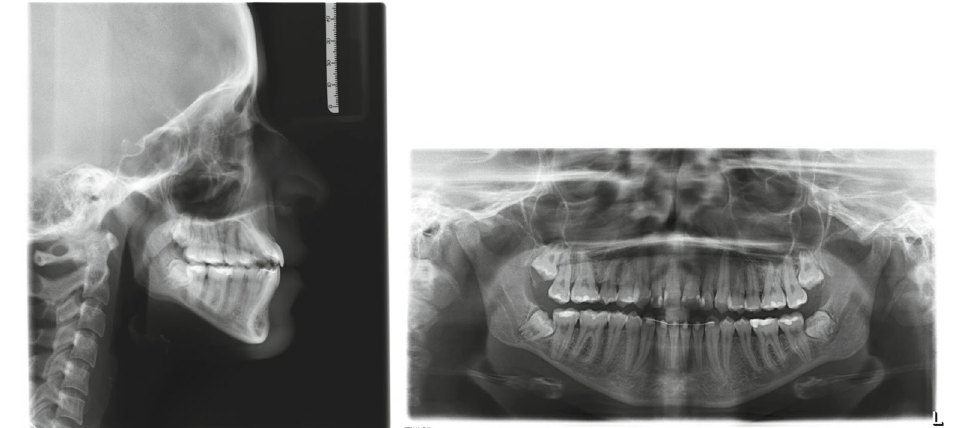
Figure 8: Posttreatment cephalometric and panoramic